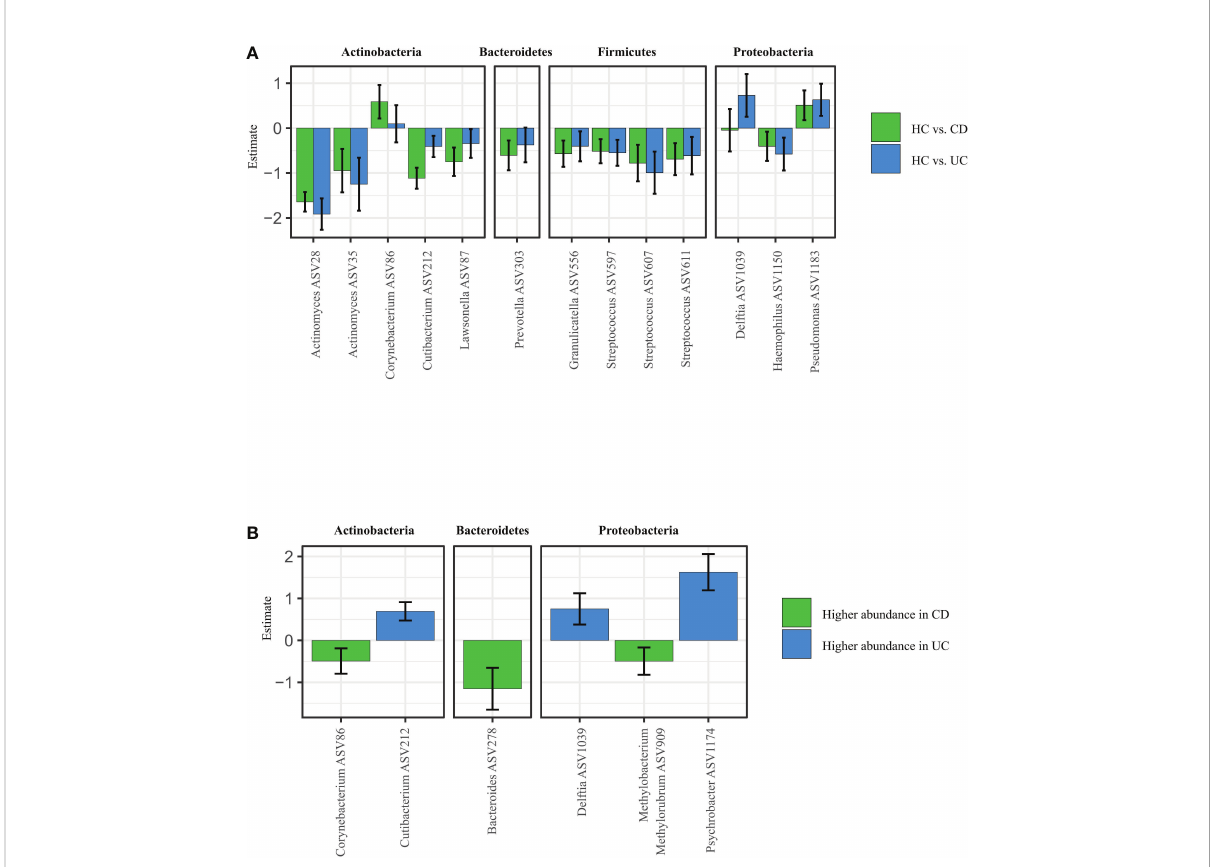
FIGURE 2 Speci fi c microbiota pattern at the retroauricular crease distinguishes CD, UC and healthy controls. (A) Differential abundance analysis (DAA) of ASVs between CD and UC versus HC. Model estimates and 95% con fi dence intervals are shown. Positive and negative values indicate an increase and decrease in abundance, respectively, in the IBD groups compared with HC. Green color indicates ASVs abundance changes in CD compared to HC and blue color abundance changes between UC and HC. (B) Signi fi cant differences in taxa between CD and UC assessed by Differential abundance analysis. The taxa with signi fi cantly higher abundances in CD over UC patients are shown as negative estimates (color- coded in green), and the taxa with signi fi cantly higher abundances in UC over CD patients are shown as positive estimates (color-coded in blue). ASVs with relative abundance of more than 0.01% in all samples and detected in at least 10% samples were used in DAA analysis. CD, Crohn ’ s disease; UC, ulcerative colitis; HC, healthy